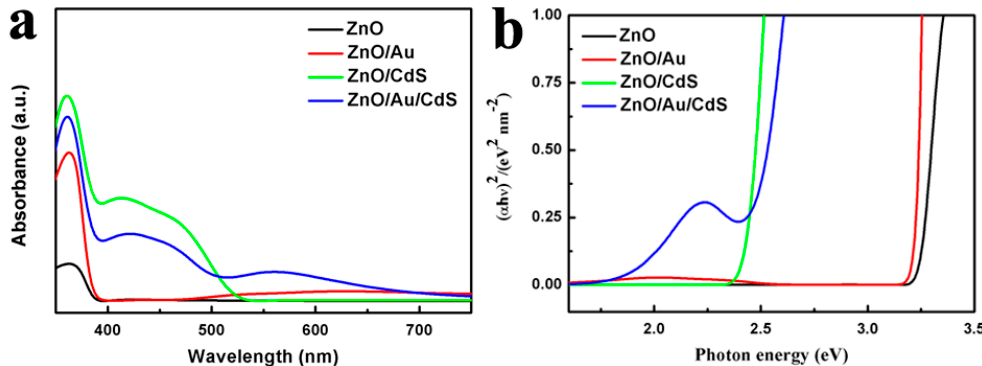
Figure 5. ( a ) UV-vis absorption spectra and ( b ) ( ahv ) 2 -photon energy curves of the ZnO, ZnO/Au, ZnO/CdS, and ZnO/Au/CdS samples.